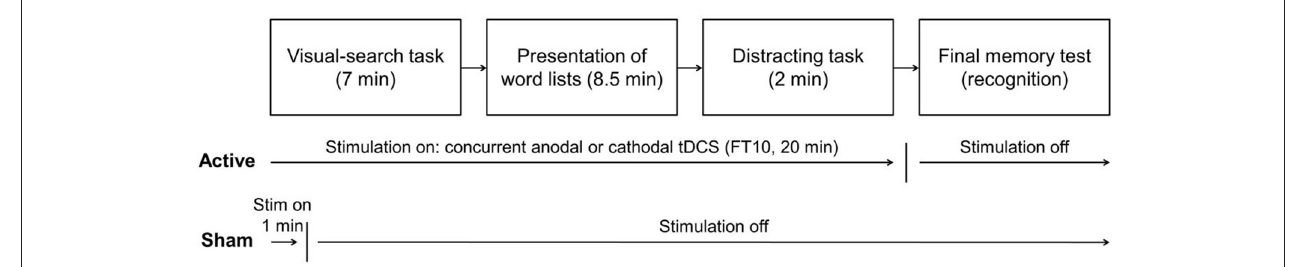
FIGURE 1 | Schematic representation of the experimental procedure.